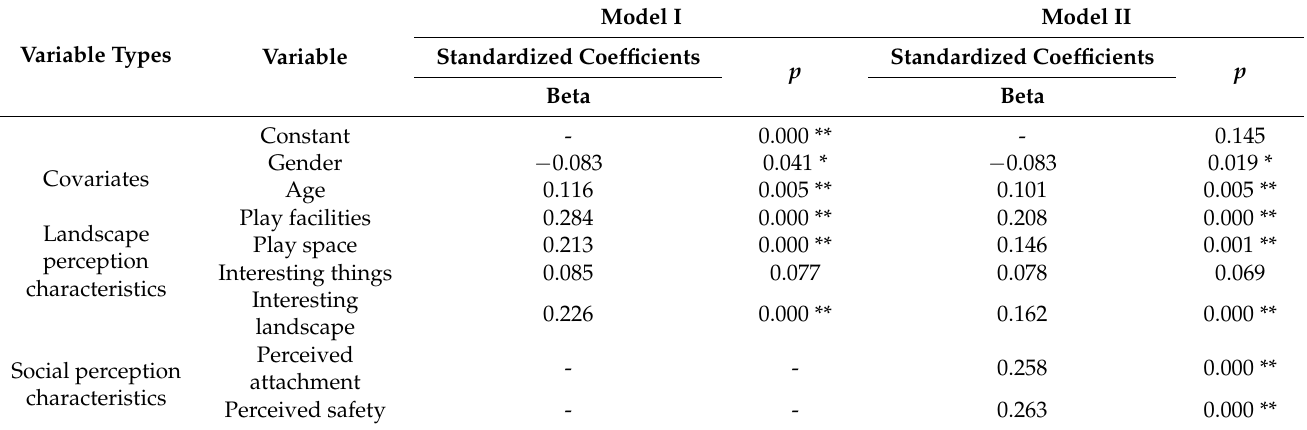
Table 6. Results of multi-layer regression equation